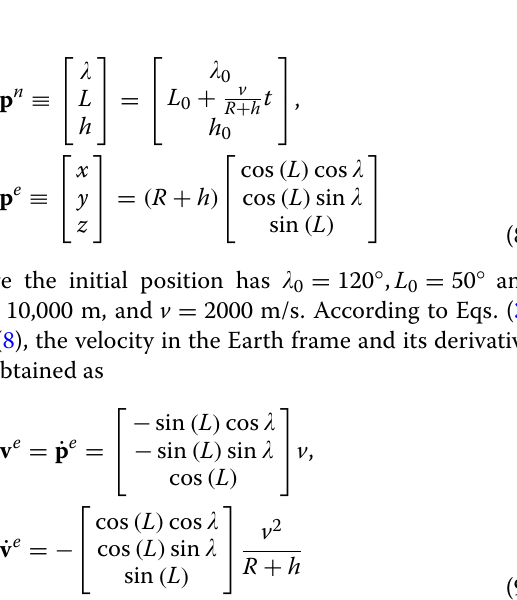
e = I 3 and substituting into Eq. (2) pro- Recalling C b duce the specific force measured by accelerometers × v e − g e f b = ˙ v e + 2 ω e . And then according to Eq. (1), ie